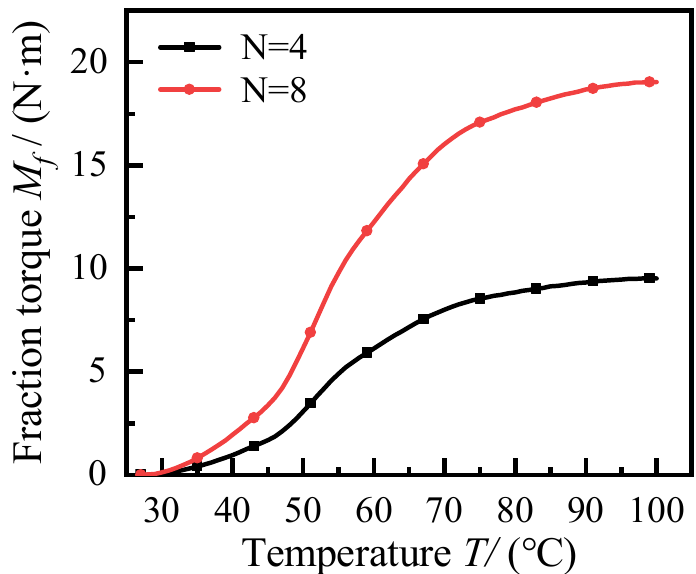
Figure 9. SMA spring temperature and friction torque curves. To illustrate the superior performance of this intelligent fan clutch, it is compared with the F450 type fan clutch, a 103 kW LR6ALR22/1030 supercharged engine radiator with a matching F450 fan diameter D of 450 mm, combined with the fan torque speed calculation formula shown in Equation (12), where the torque coefficient in air K a is 0.96 and air density ρ is 1.293 kg/m 3 while assuming a constant clutch input speed n 0 of 3000 rad/min. The calculated fan torque versus speed is shown in Figure 10. It can be seen from the figure that when the load torque increases, the fan speed growth rate gradually decreases; when the fan speed is 3000 rad/min, the corresponding load torque is 20.7 N · m.